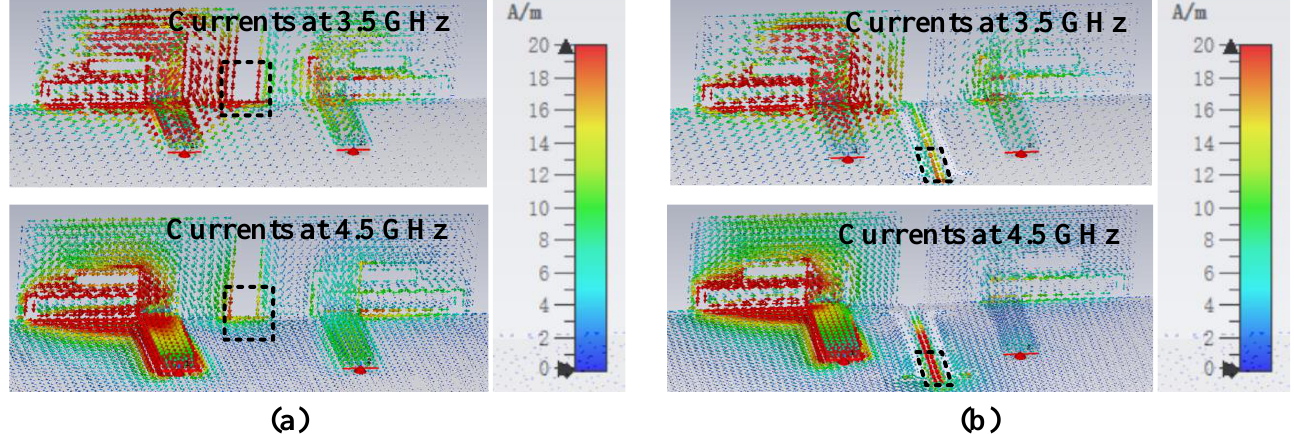
Figure 7. Comparisons of current distributions. ( a ) Case 3. ( b ) Case 4.